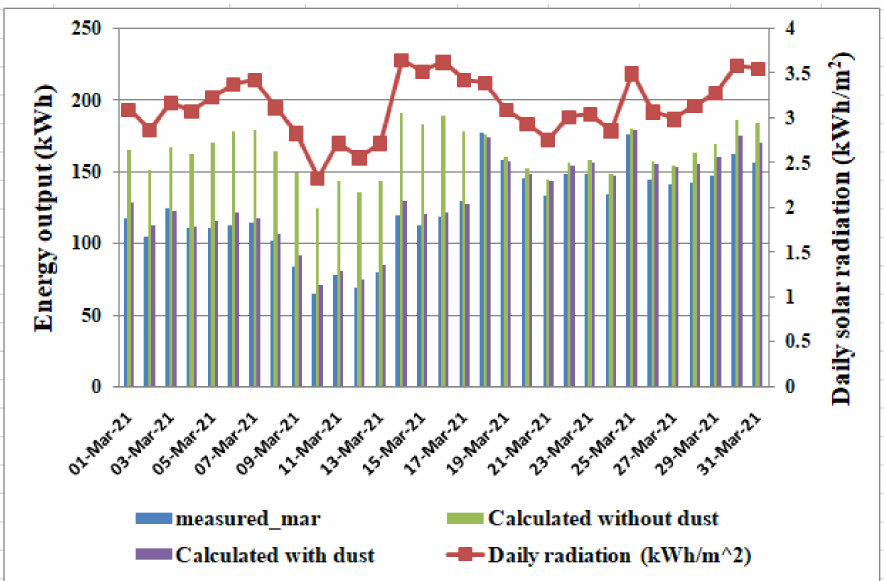
Figure 5. Comparison among measured plant generation, and model based calculated generation with and without dust from 1 March 2021 to 31 March 2021 at RBI, Kolkata (22.57 ◦ N, 88.36 ◦